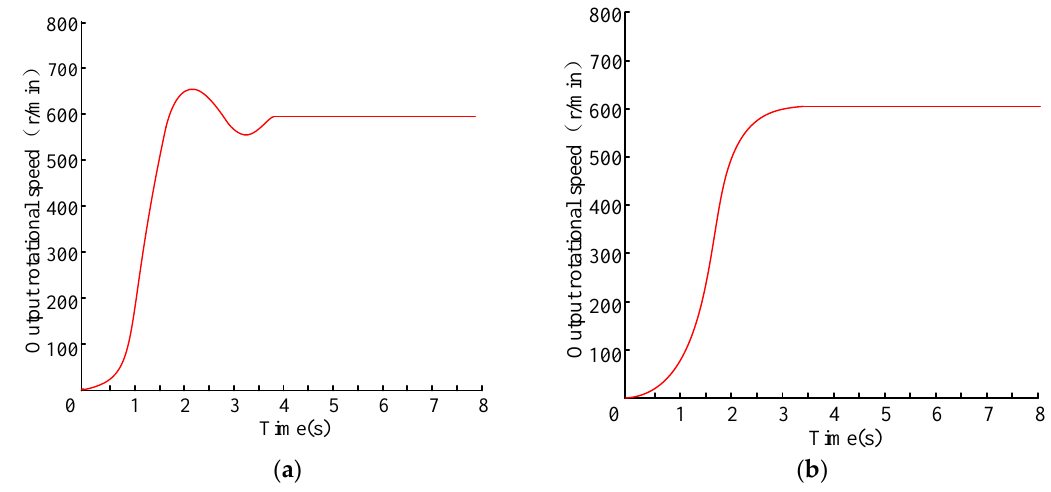
Figure 21. Comparison and analysis of control results under different condition of PMSC speed response: ( a ) PID control; ( b ) adaptive NFTSM control.